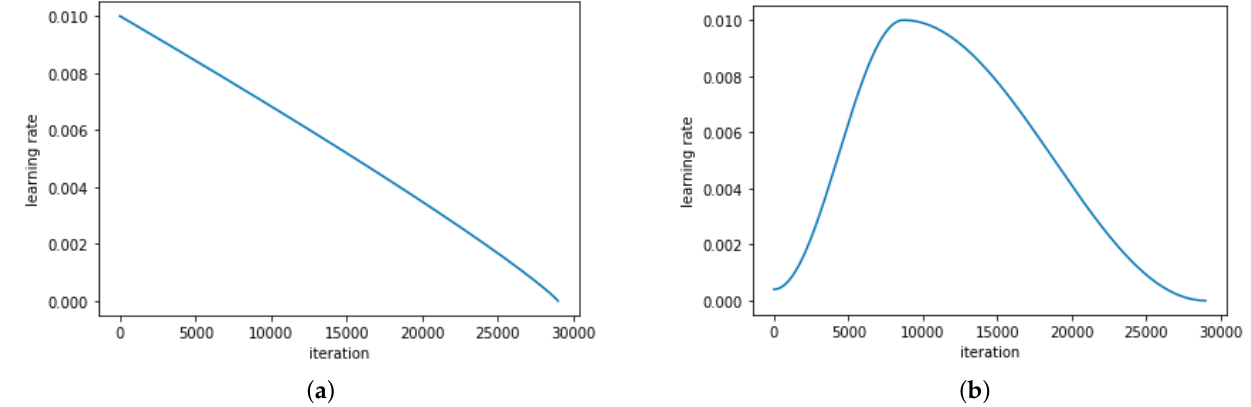
Figure 9. The two learning rate schedulers (LRS): ( a ) Poly and ( b )